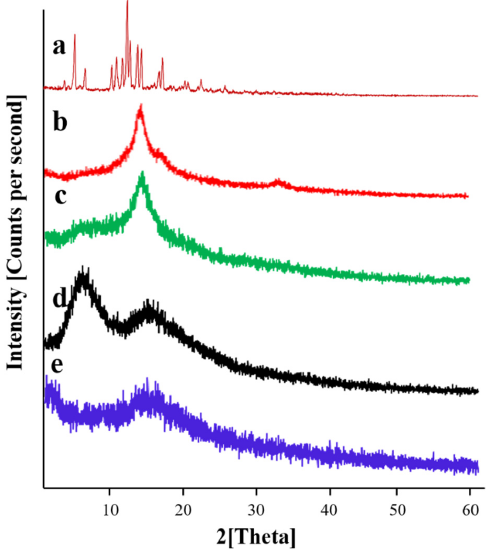
Figure 8. PXRD diffractograms of ( a ) Simvastatin, ( b ) PVA, ( c ) Thiolated chitosan, ( d ) PVP and ( e ) Simvastatin-loaded dMNPs.